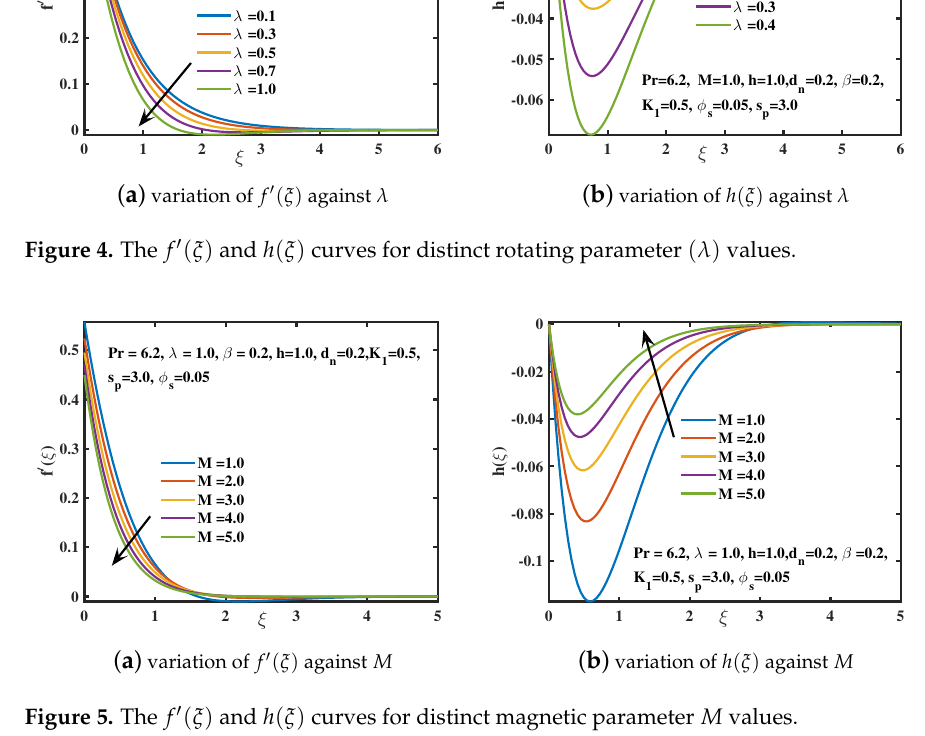
Figure 5. The f (cid:48) ( ξ ) and h ( ξ ) curves for distinct magnetic parameter M